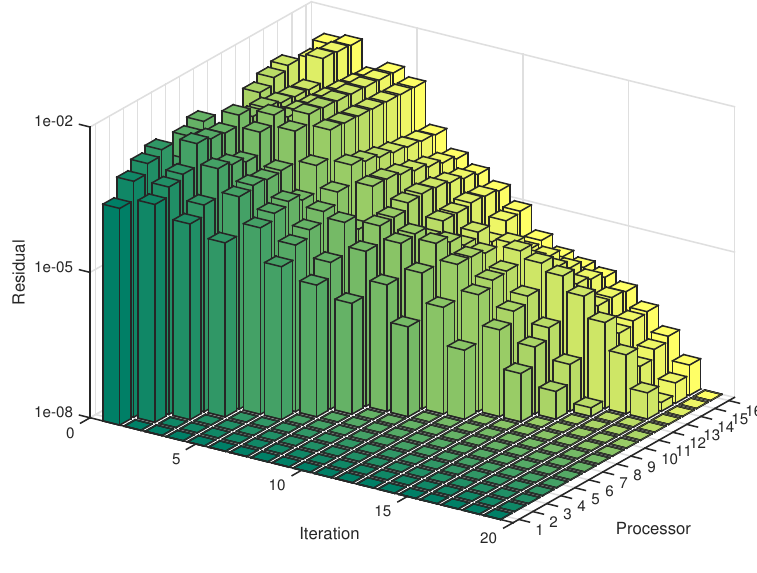
Figure 5. Asynchronous parareal iterations for 16 cores. Unlike other asynchronous methods, parareal scheme performs as a tidy convergent process.